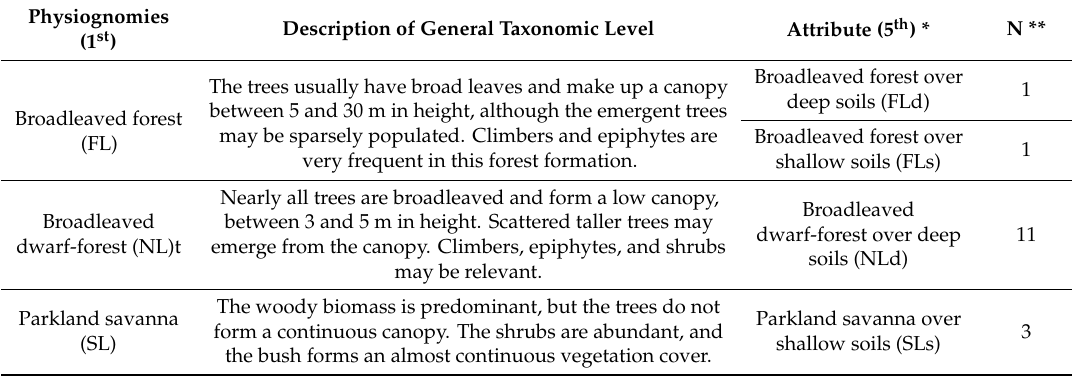
Table 1. Phytophysiognomies considered at the two taxonomic levels